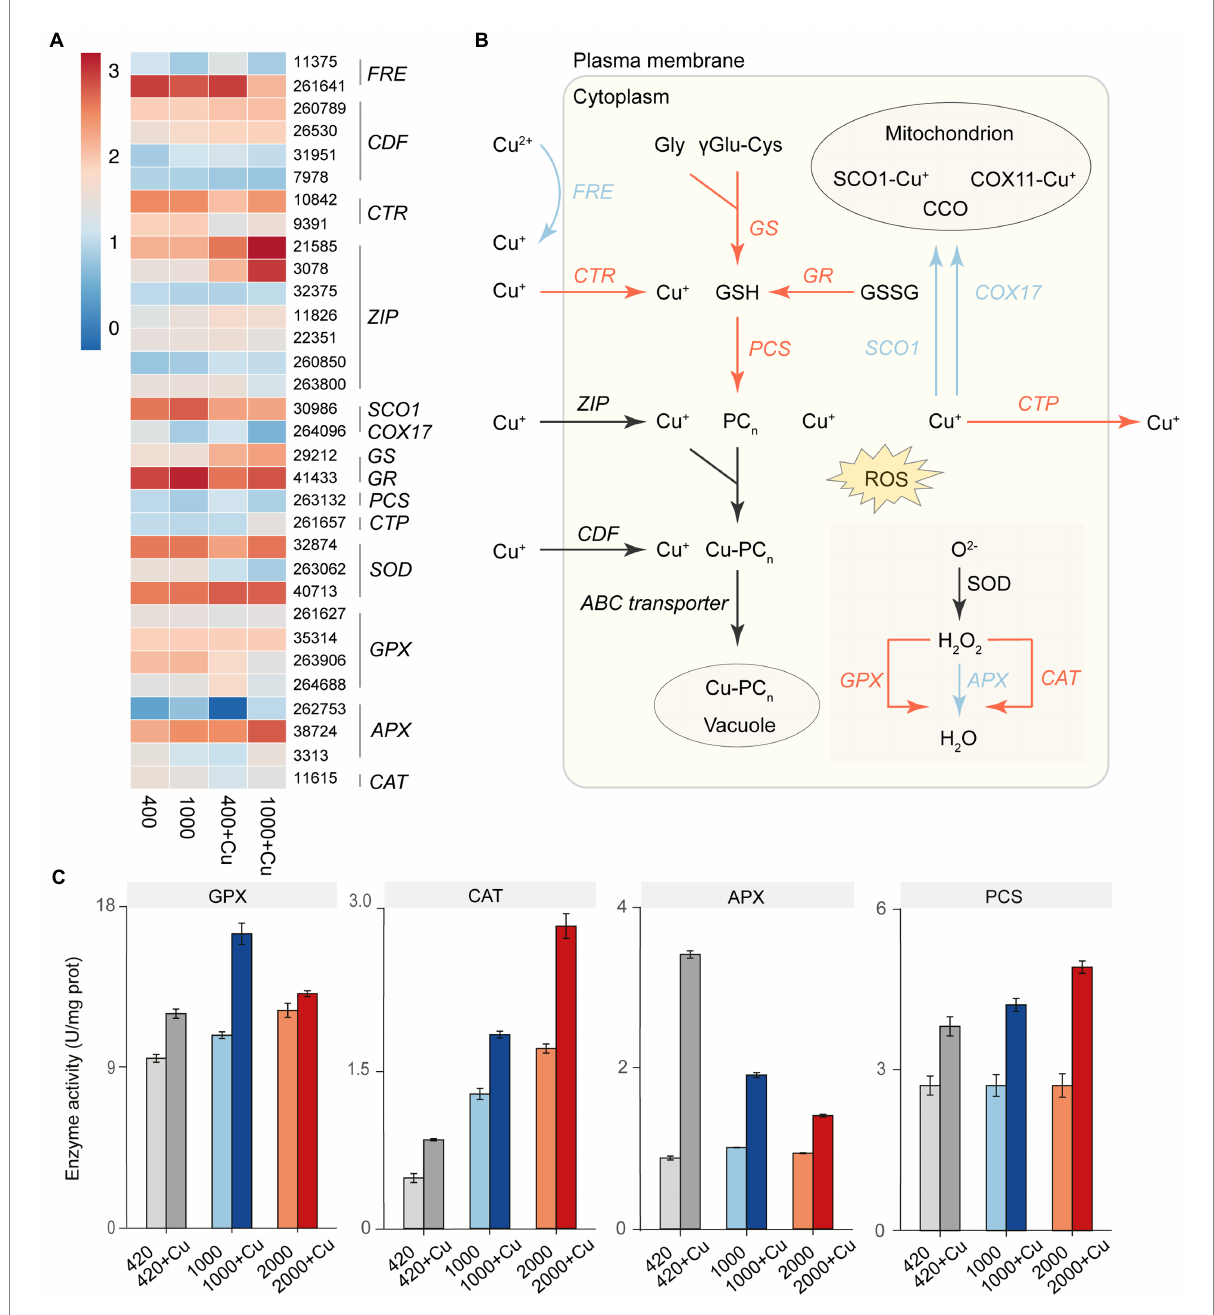
FIGURE 4 The effect of elevated p CO 2 on genes expression and enzyme activity involved in the copper metabolic pathway of T. pseudonana . (A) Heat map of representative gene expression in copper metabolic pathway of T. pseudonana under elevated p CO 2 with or without copper exposure. (B) Schematic of the altered copper metabolic pathway in T. pseudonana under elevated p CO 2 . Arrows in red or blue represented the up-or down-regulated genes under elevated p CO 2 . Black arrows indicated that there were not consistent variation trends for the functionally similar genes with different ID number. (C) Activities of three antioxidant enzymes (units/mg protein), including, glutathione peroxidase (GPX), ascorbate peroxidase (APX), and catalase (CAT) under elevated p CO 2 with or without copper